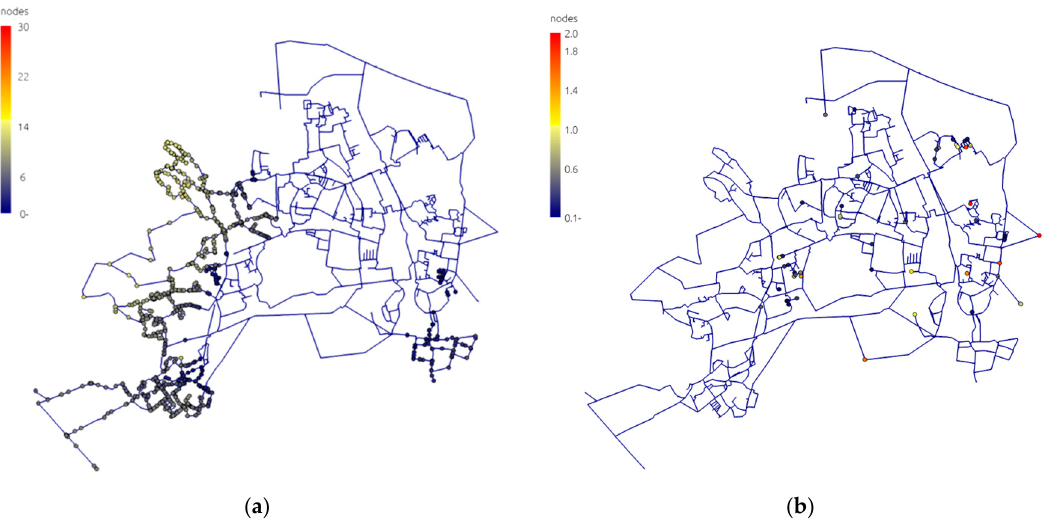
Figure 3. Maximum pressure violation in the simulation period for ( a ) the currently existing infrastructure and ( b ) the network